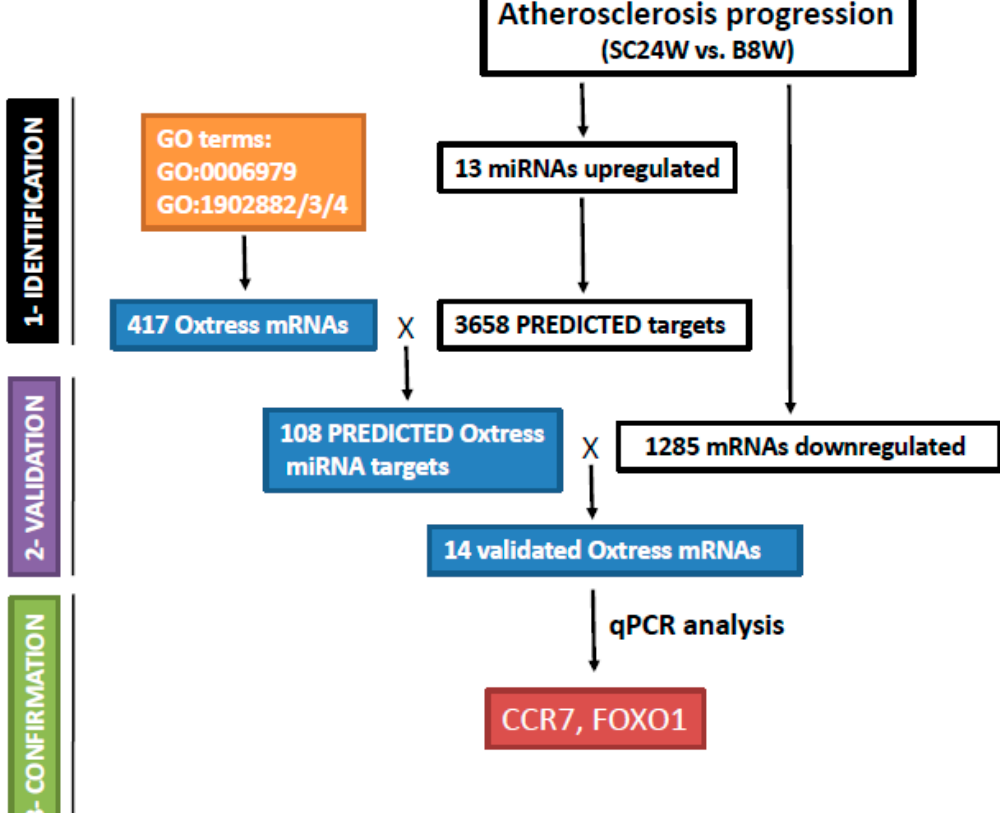
Figure 1. Diagram of the experimental approach used to identify putative miRNA-regulated Oxstress genes in atherosclerosis progression. Expression profiling of ATHp (SC24W vs. B8W, step 1, upper left box) had previously allowed the detection of 13 upregulated miRNAs, 1285 downregulated mRNAs, and 3,658 predicted miRNA targets [15,16]. A reverse GO term analysis of oxidative stress genes yielded 417 mRNAs for the primary GO:0006979 (response to oxidative stress) and its child terms GO:1902882 / 3 / 4 (see text for more details). This list was crossed with the list of 3658 predicted miRNA targets (see Materials and Methods) and the 108 entries common to both lists, likely representing Oxstress genes targeted by any of the 13 miRNAs, were saved. The list of 108 entries was crossed the list of 1,285 downregulated mRNAs to identify those actually downregulated during ATHp (step 2, middle left box). Expression of the 14 entries common to both lists (validated Oxstress mRNAs) was tested by qPCR to confirm their involvement in ATHp (step 3, lower left box). Steps 1 and 2 were made in mice or with mice data, step 3 was made with human material. The boxes shadowed in colors correspond to the work here performed, while clear boxes correspond to the work previously described [15,16].